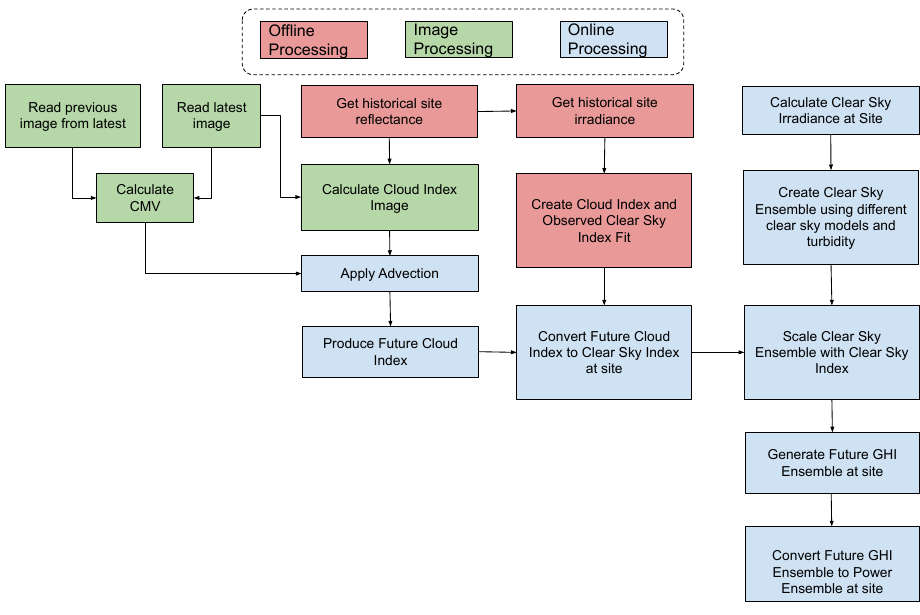
Figure 1. Flowchart representing the basic operations of SIFM.